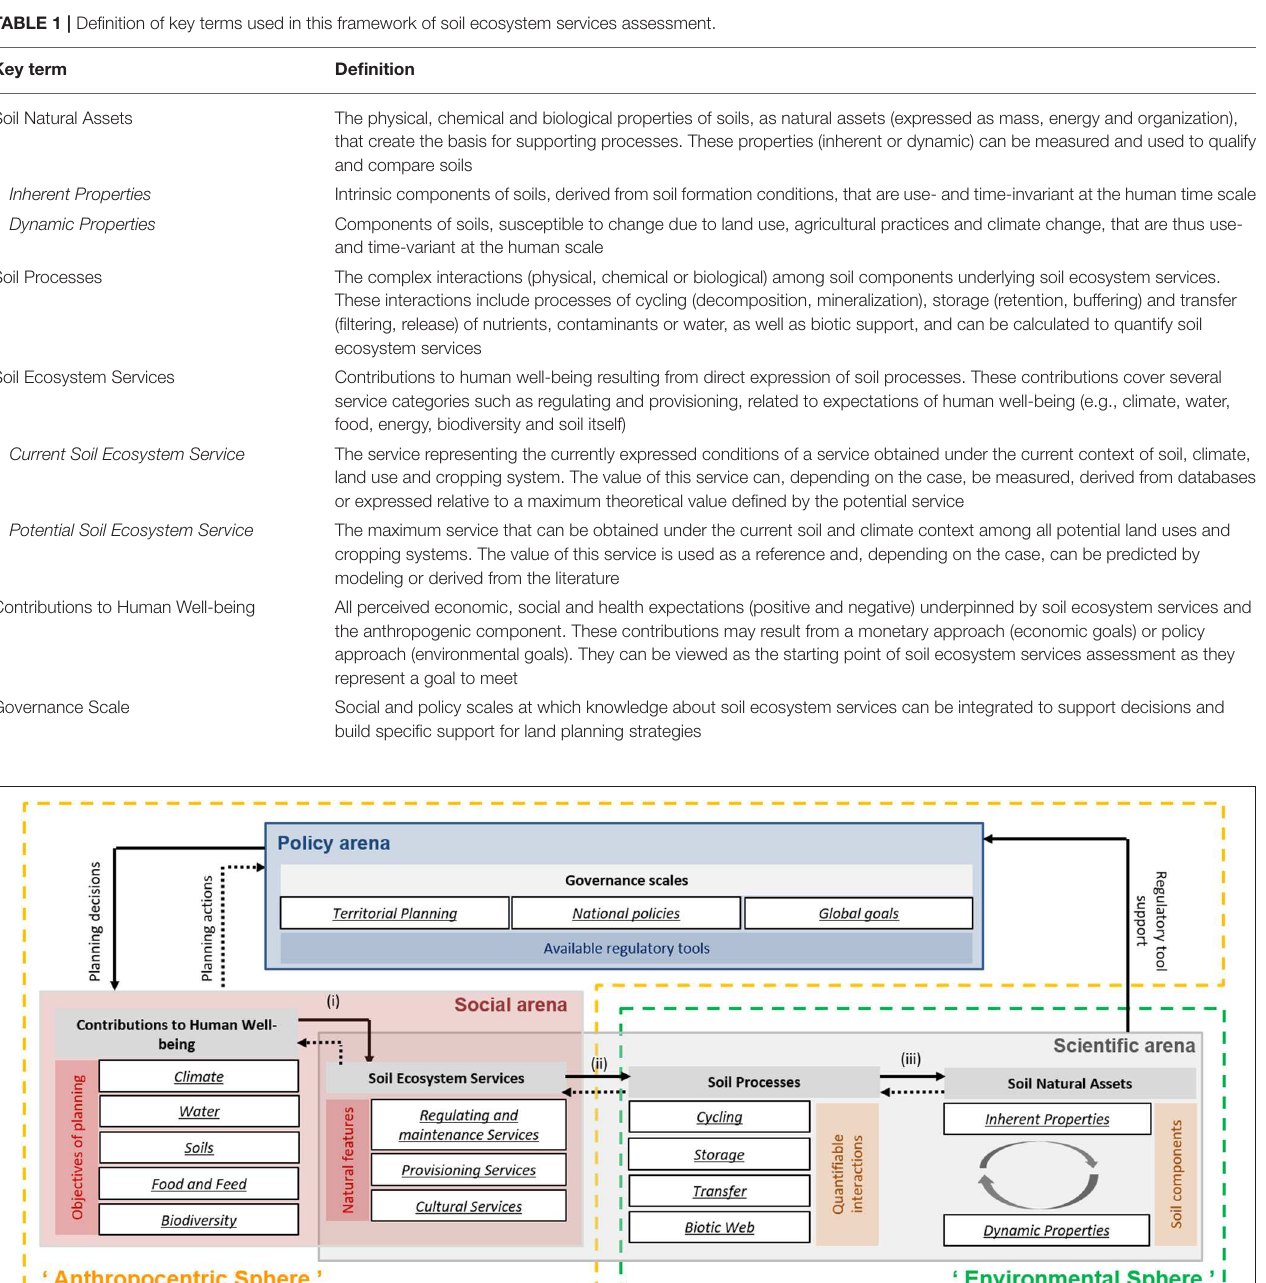
TABLE 1 | Definition of key terms used in this framework of soil ecosystem services assessment.